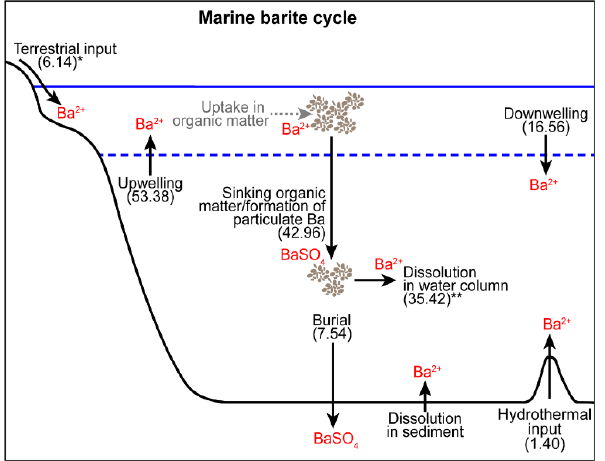
Figure 2. A simplified diagram of the marine barite cycle. Direction of fluxes are shown with black arrows, with the value of the flux in parentheses (in nmol cm −2 yr −1 ) [27]. The associated phase of barium (Ba) is shown in red, with Ba 2+ as the dissolved phase and BaSO 4 (barite) as the particulate phase. *—Terrestrial input includes river and groundwater discharge. **—Dissolution in sediment is included in the flux for dissolution in the water column. Note that Ba is also associated with other terrigenous and authigenic minerals not depicted in this figure (see discussion).